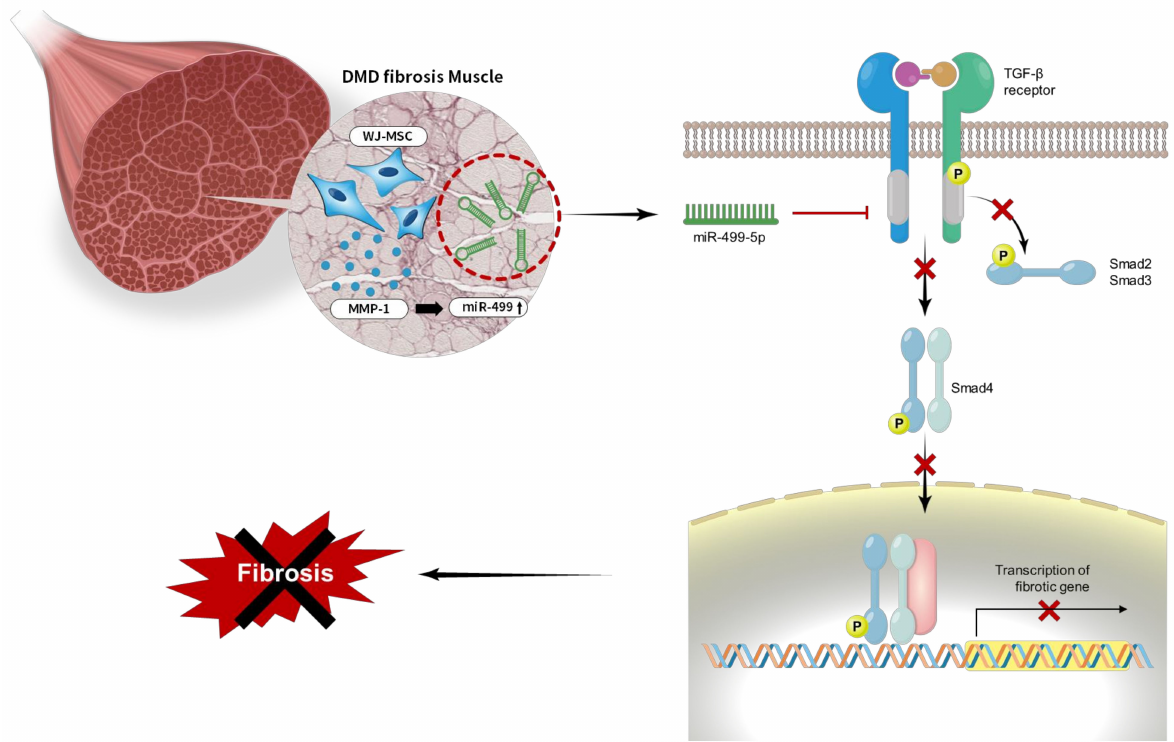
Figure 7. A model of miR-499-dependent anti-fibrotic signaling pathway. Overall proposed model of the anti-fibrotic mechanism of miR-499-5p in skeletal muscles in Duchenne muscular dystrophy (DMD). The activation of TGF β signaling pathway induces fibrosis. Our findings suggest that MMP-1 secreted from WJ-MSCs increases miR-499 expression level. Increased miR-499-5p down-regulates to the TGF β receptor I and blocks smad2/3 phosphorylation, leading to fibrotic muscle recovery by the inactivated TGF β signaling pathway